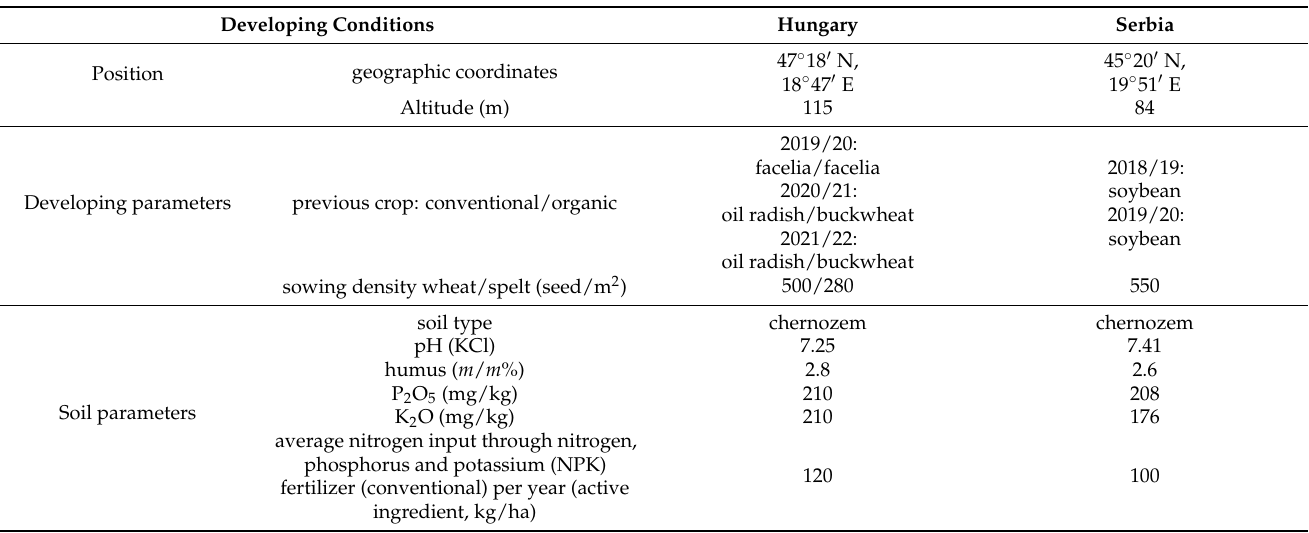
Table 2. Developing and environmental conditions of different farming systems during three growing seasons (2018/2019, 2019/2020 and 2020/2021) in Hungary and two growing seasons (2018/2019 and 2019/2020) in Serbia.